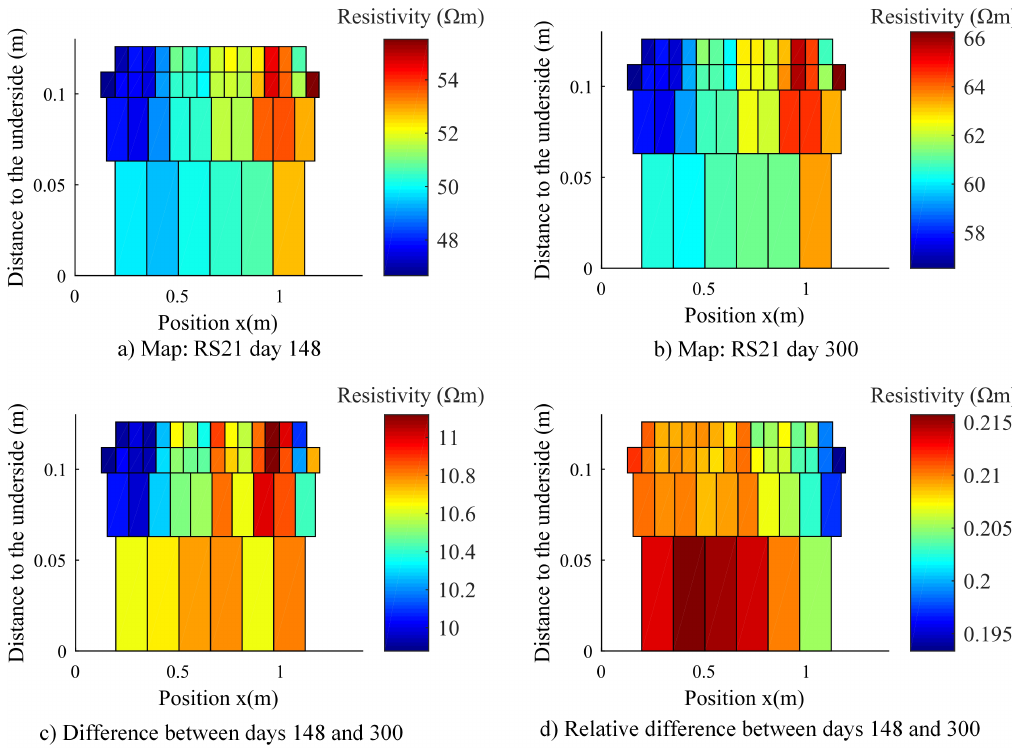
Figure 19. Example of pseudo section of apparent resistivity measured in beam 1 by sensor RS 11, 148 days after casting in concrete ( a ), 300 days after casting in concrete ( b ), ( c ) is the difference between the two pseudo sections of resistivity and ( d ) the relative